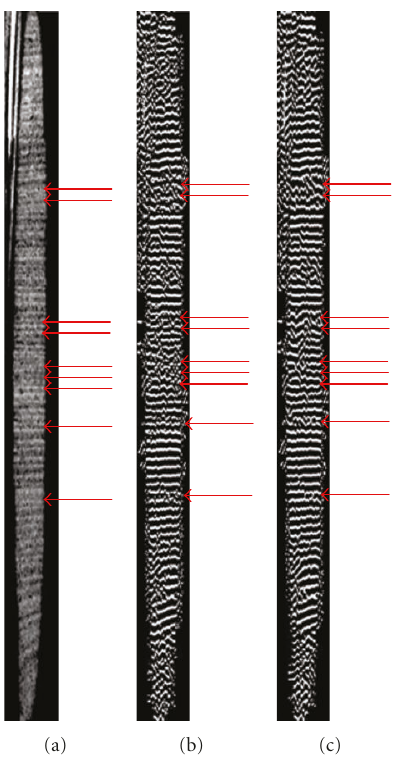
Figure 8: DCA Comparisonexample (populus sample):(a)original image. (b) FM image without median filter. (c) FM image with median filter correction (69 × 69). The red arrows indicate the image regions where the median filter correction has significantly improved the continuity in the reconstructed